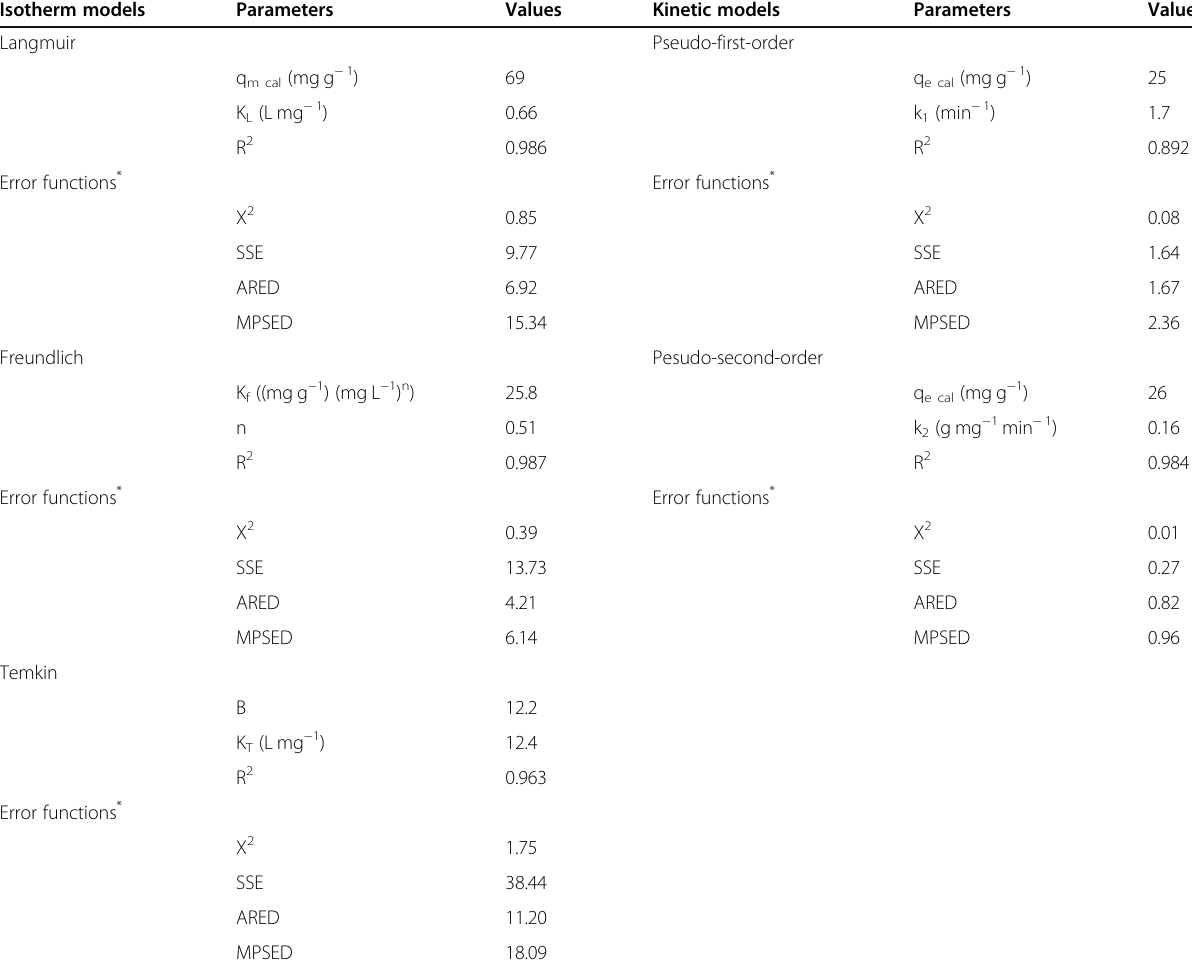
Table 4 Nonlinear isotherm, kinetic parameters, regression coefficients and error functions for Ni (II) removal using rGO-X-25 Isotherm